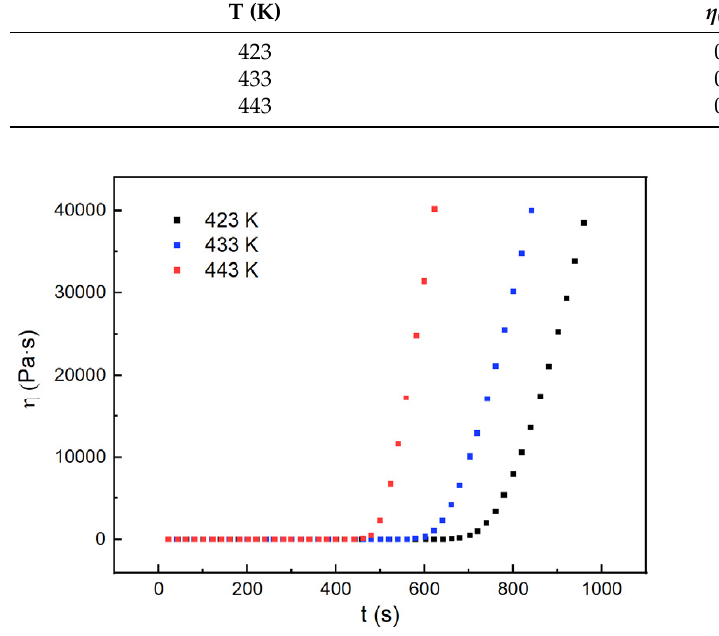
Figure 16. The viscosity of the H 6 XDI/BES system with time at constant temperatures. The η 0 values were put into Equation (22), and the calculated results are shown in Figure 17.